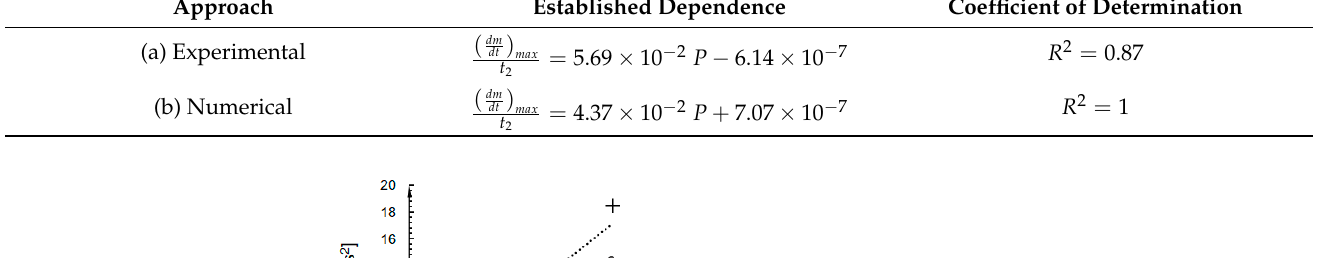
Table 3. Dependences of (cid:4672) (cid:3031)(cid:3040) mental, (b) numerical approach .